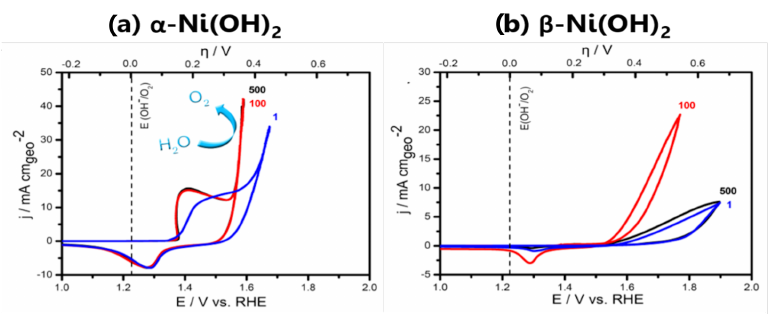
Figure 8. Comparison of cyclic voltammograms after 1, 100, and 500 cycles in KOH 1M for ( a ) α -Ni(OH) 2 , and ( b ) β -Ni(OH) 2 . Modified from